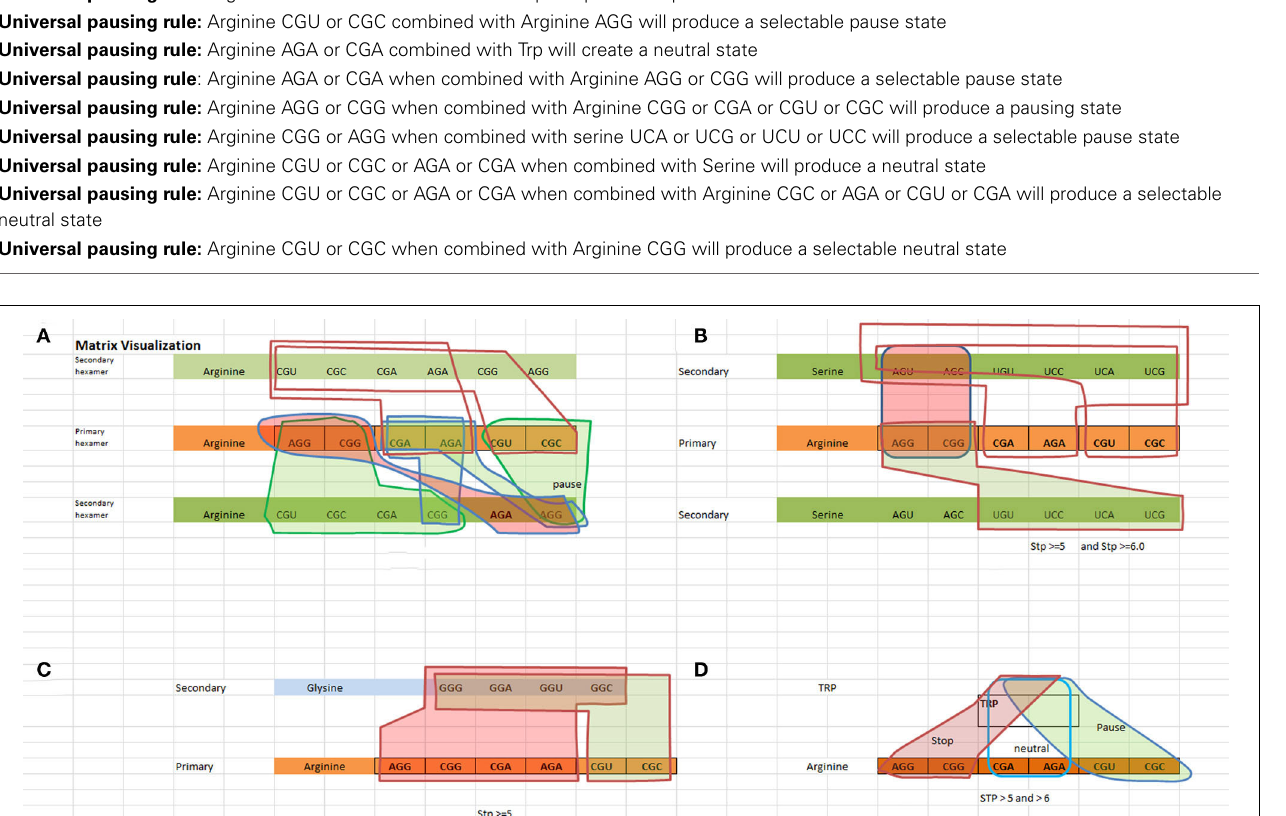
any one of the red highlighted serine codons represents a “not allowed” state. For example, [AGG ACU] or [AGG AGC] or [CGG AGU] or [CGG AGC] are not allowable. Hexamers [AGG UGU] or [AGG UCC] or [AGG UCA] or [AGG UCG] or [CGG UGU] or [CGG UCC] or [CGG UCA] or [CGG UCG] involve some level of pausing, while hexamers such as [CGA AGU, ... ] represent a neutral state i.e., no pausing. (C) Visualizes the states for a Arginine–Glysine hexamer. (D) Visualizes the states for a Arginine–Trp